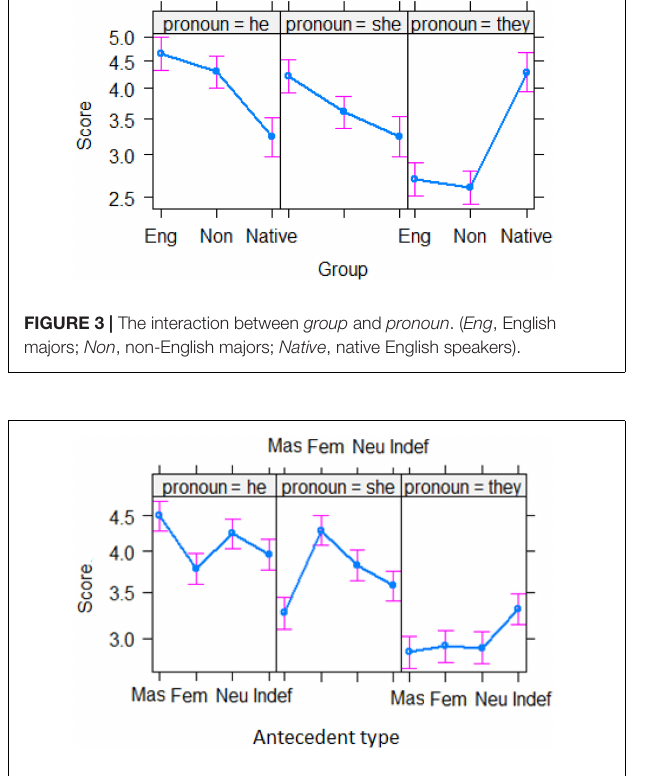
FIGURE 4 | The interaction between antecedent and pronoun . ( Mas , masculine; Fem , feminine; Neu , neutral; Indef , indefinite).